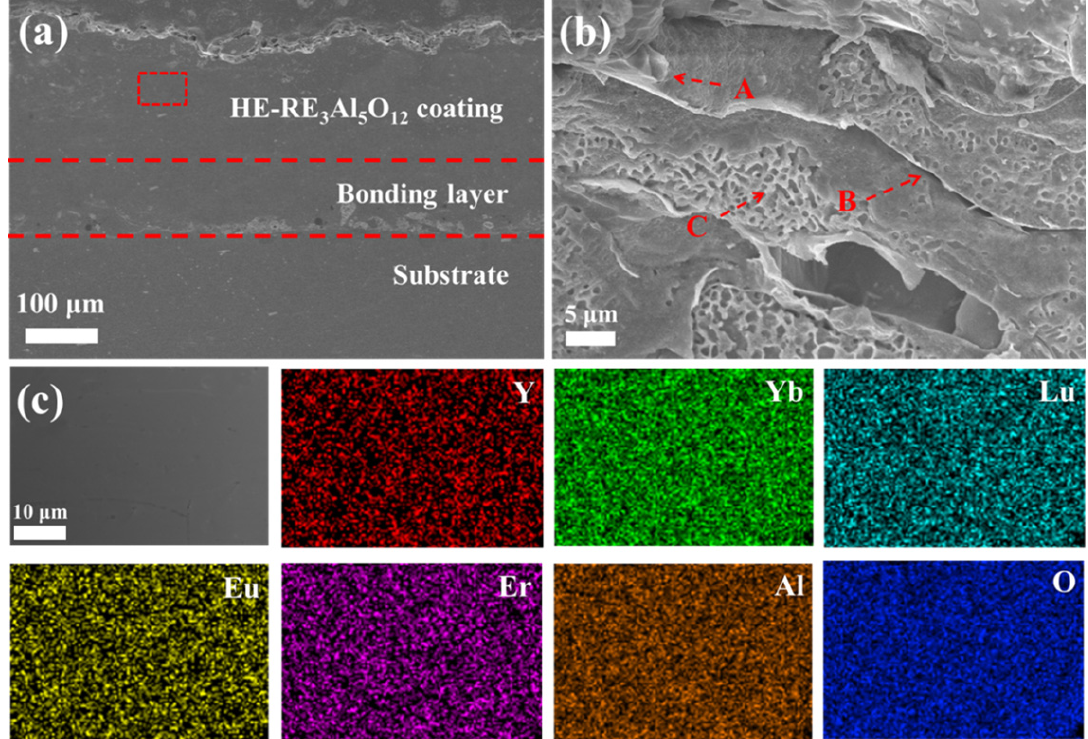
Fig. 7 SEM images of the plasma-sprayed HE-RE 3 Al 5 O 12 -3 coatings: (a) cross-section image; (b) morphology of the fracture surface. (c) EDS elemental mappings of the polished cross-section (red rectangle area in HE-RE 3 Al 5 O 12 -3 coating of (a)). solidification of droplets during the spraying